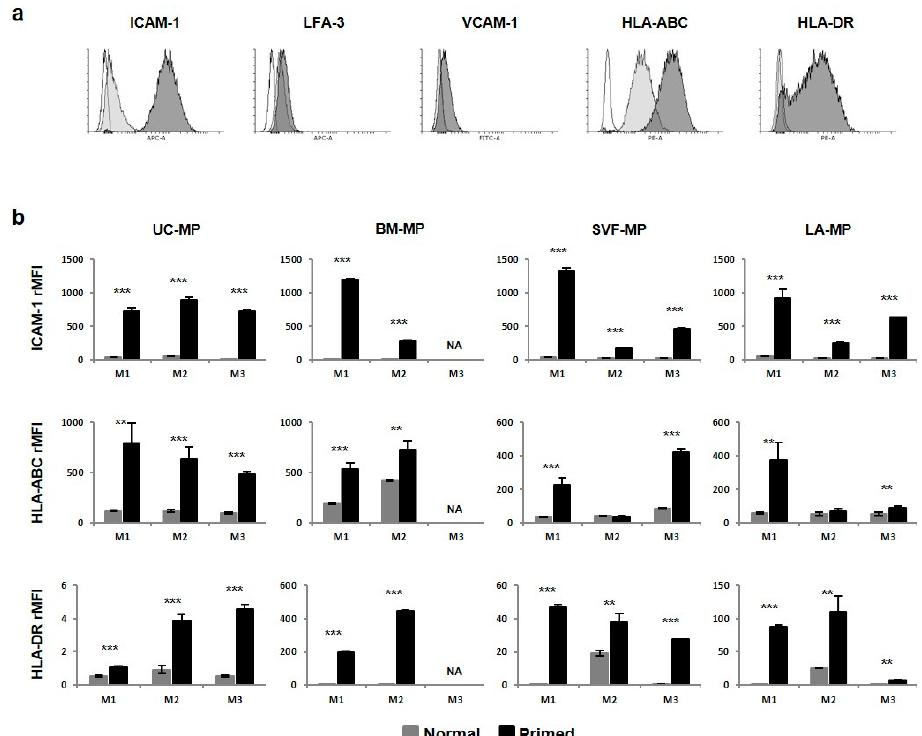
Figure 6. Flow cytometry analysis of adhesion and HLA molecules in tissue-specific MSC-based MPs. ( a ) Representative histograms show expression of ICAM-1, LFA-3, VCAM-1, HLA-ABC and HLA-DR in normal (colored light grey) and primed (colored dark grey) MPs versus isotype control (black line). ( b ) Results are expressed as relative mean fluorescence intensity (rMFI) and compared between normal and primed MPs expanded in M1, M2 and M3 media. Results refer to the mean ± SD, n = 3. Statistics: unpaired t test (** p < 0.01, *** p < 0.001). NA—not